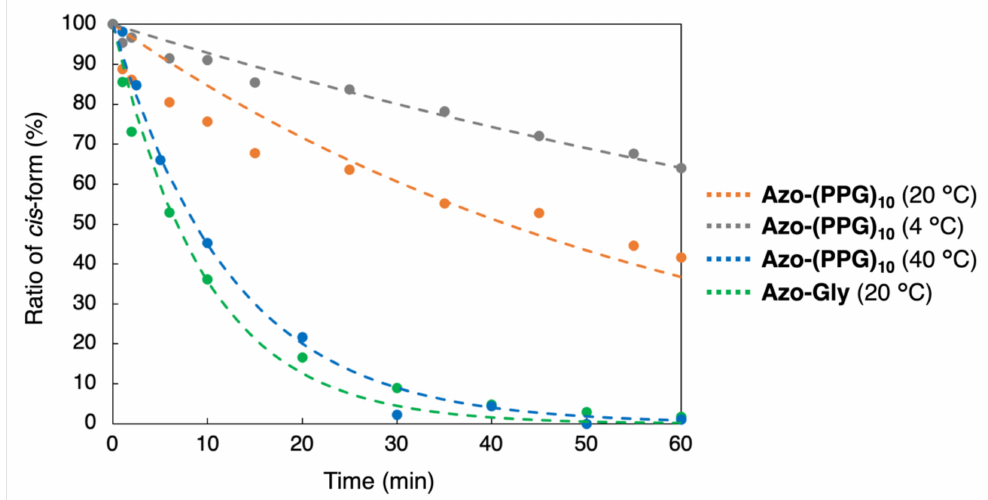
Figure 6. Curve fitting for the cis -to- trans isomerization of the azobenzene moiety.